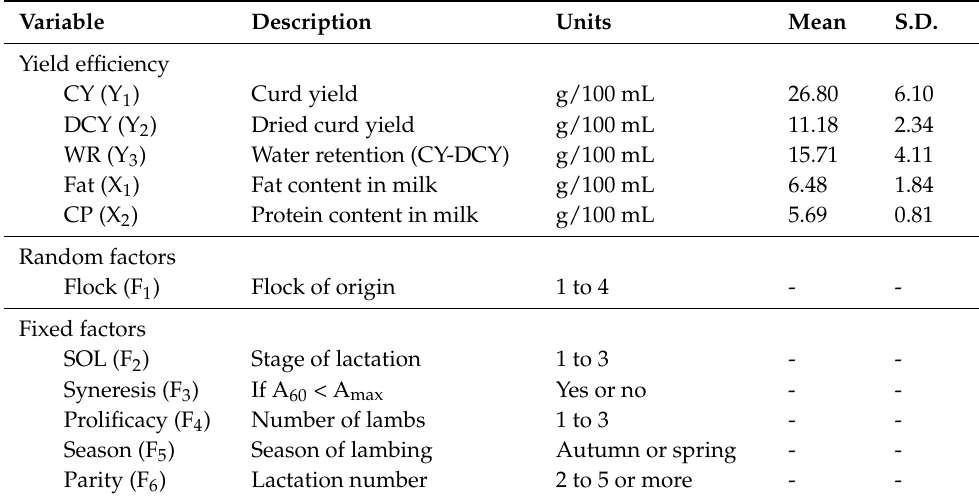
Table 2. Description of the variables used to estimate yield efficiency and causes for inefficiency in Manchega sheep milk ( n =